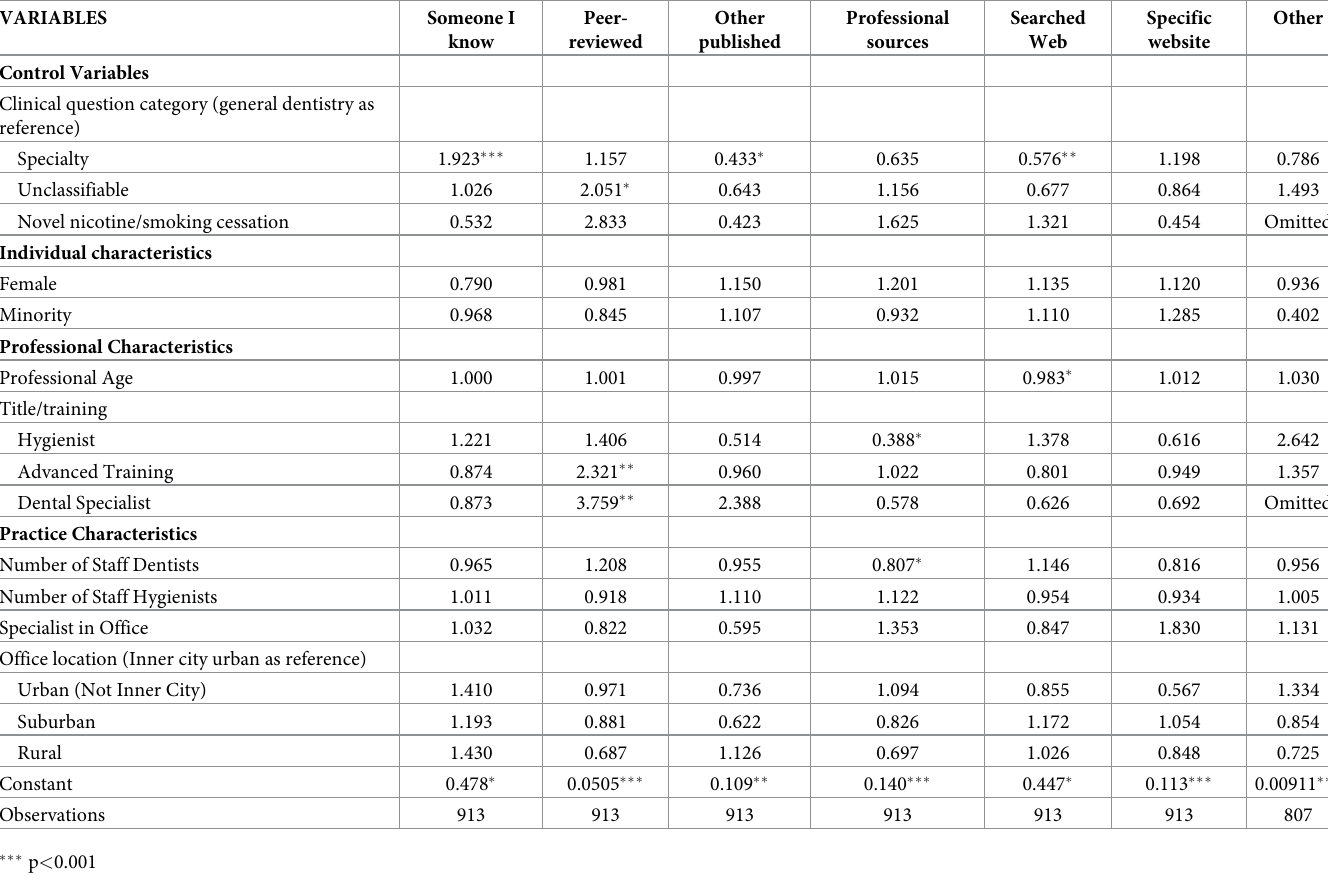
Table 2. Logit models of first search sources for self-nominated clinical topics (odds ratios